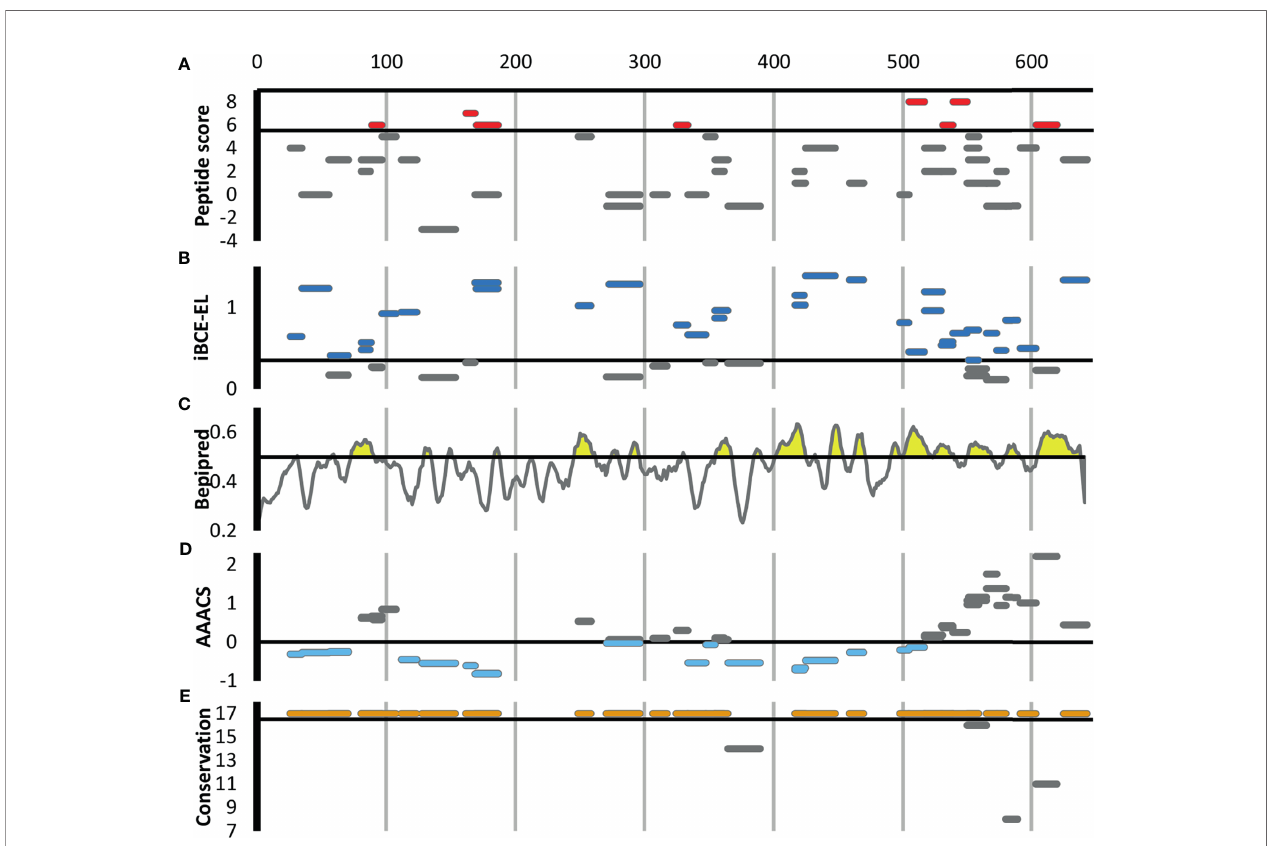
FIGURE 3 | Scoring for the 46 F. tularensis DnaK peptides detected in at least two Experiment samples. The short horizontal line segments in A, B, E and F indicate the position of a peptide along the length of the 642aa DnaK protein, and its vertical position within each fi gure panel indicates its score for the metric indicated. The default score threshold for each tool is shown with a horizontal line, and the peptides or per-amino acid scores exceeding that threshold are shown in color. (A) Peptide enrichment score based on our proteomics results. An enrichment score of 8 indicates that the peptide was detected in greater abundance in all 8 Experiment samples relative to their respective Control samples. The threshold for inclusion in Table 1 was an enrichment score of ≥ 6 (shown in red). (B) B-cell epitope prediction score generated using iBCE-EL. At the default iBCE-EL score threshold of 0.35, nearly three quarter of all peptides were predicted to be likely B- cell epitopes (shown in dark blue). (C) B-cell epitope prediction score generated using Bepipred 2.0. The per-amino acid scores are indicated by the line graph. At the default iBCE-EL score threshold of 0.35, 37% of all amino acids were predicted to be in B-cell epitopes (regions of the graph shown in yellow). (D) Average Amino Acid Conservation Score (AAACS) based on Consurf analysis. Negative scores indicate greater degrees of evolutionary conservation (shown in light blue). (E) Number of fully sequenced F. tularensis subsp. tularensis genomes (17 analyzed) in which each peptide occurs. Almost all of the DnaK peptides considered were conserved in all 17 Ft genomes (shown in